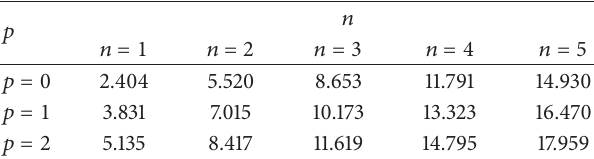
Table 1: Roots of the Bessel functions of the first kind, 𝑋 𝑛𝑝 . Table 2: Roots of the first-order derivative of the Bessel functions of the first kind, 𝑋 󸀠 𝑛𝑝